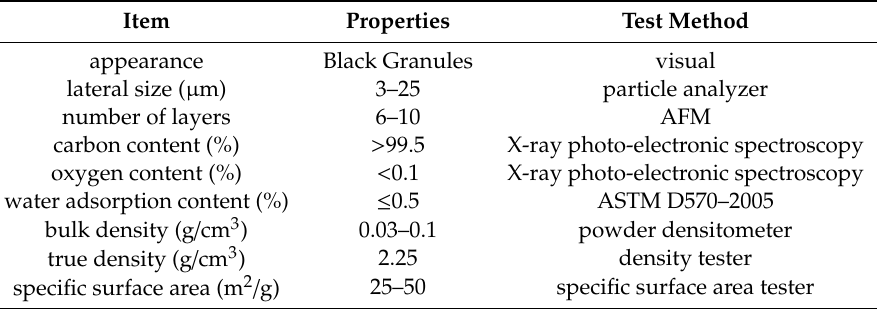
Table 3. Characteristics of graphene nanoparticles.